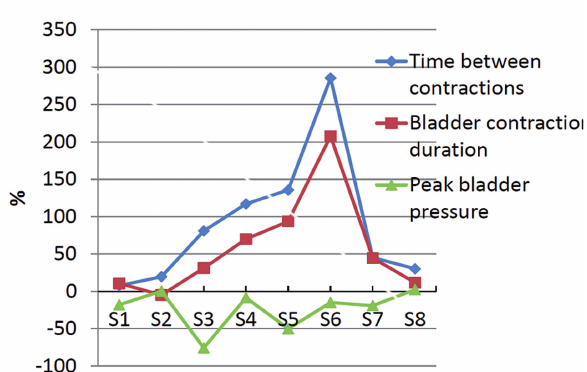
figure 3 - Changes of average values of parameters after snM treatment. The parameters, i.e. time between contractions and bladder contraction duration, for the sCI rat in the late phase of spinal shock or shortly after